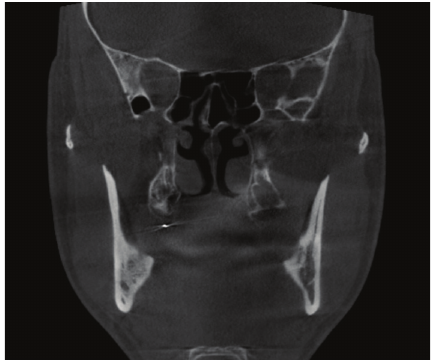
Figure 3: Axial view.